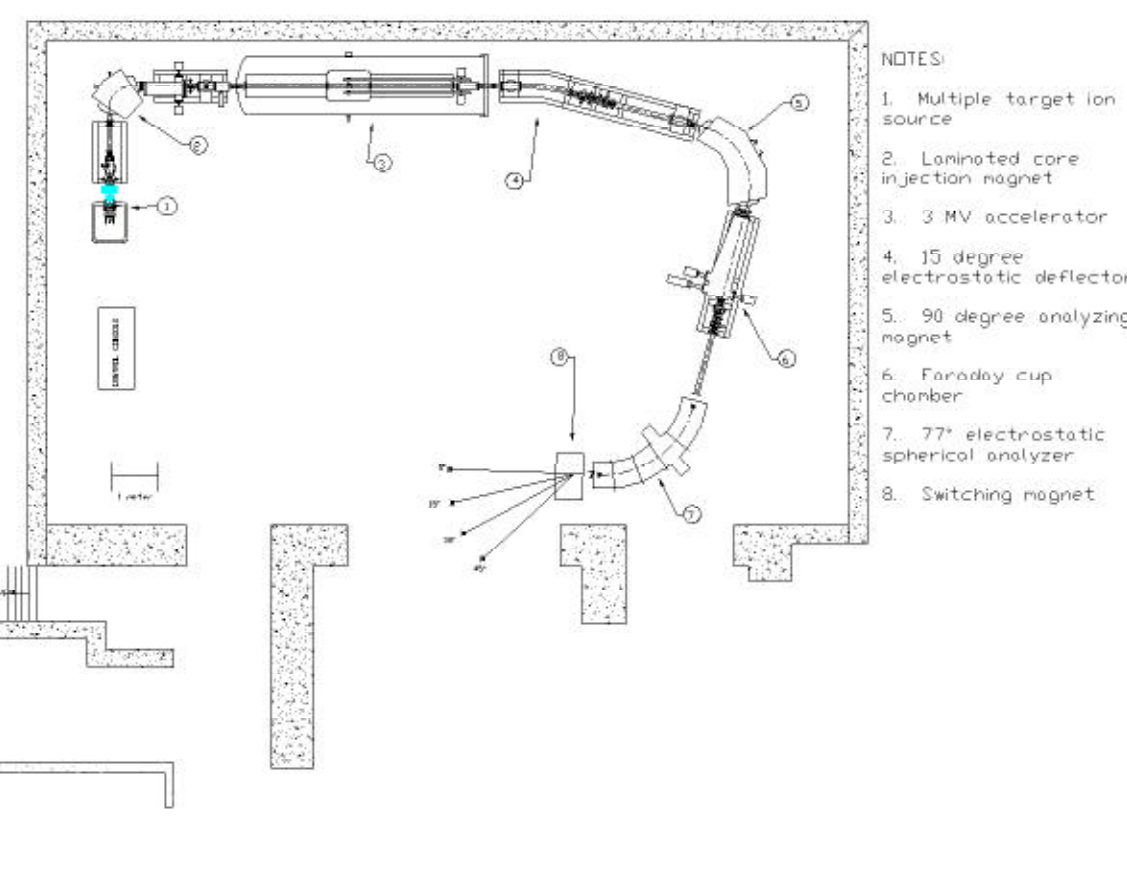
FIGURE 1. Layout of the new 3-MV Arizona AMS system, based on a 9SDH Pelletron